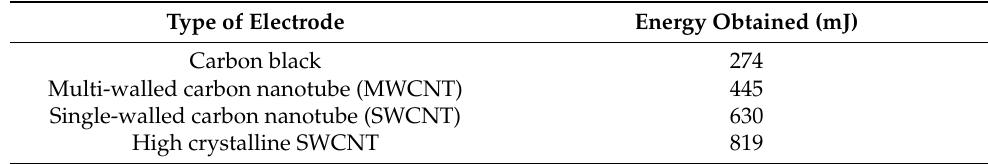
Figure 19. Drape type DEG: ( a ) buoy containing the drape type DEG having the size of 120 mm x 260 mm (no elongation state), ( b ) the time when it is extended by 60 mm from the original length by waves. Table 1. Difference in energy obtained when changing electrode material. Table 1. Difference in energy obtained when changing electrode